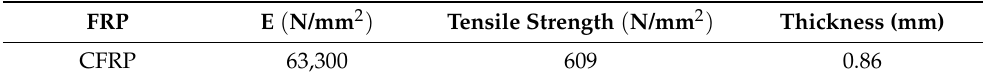
Table 3. Material properties of